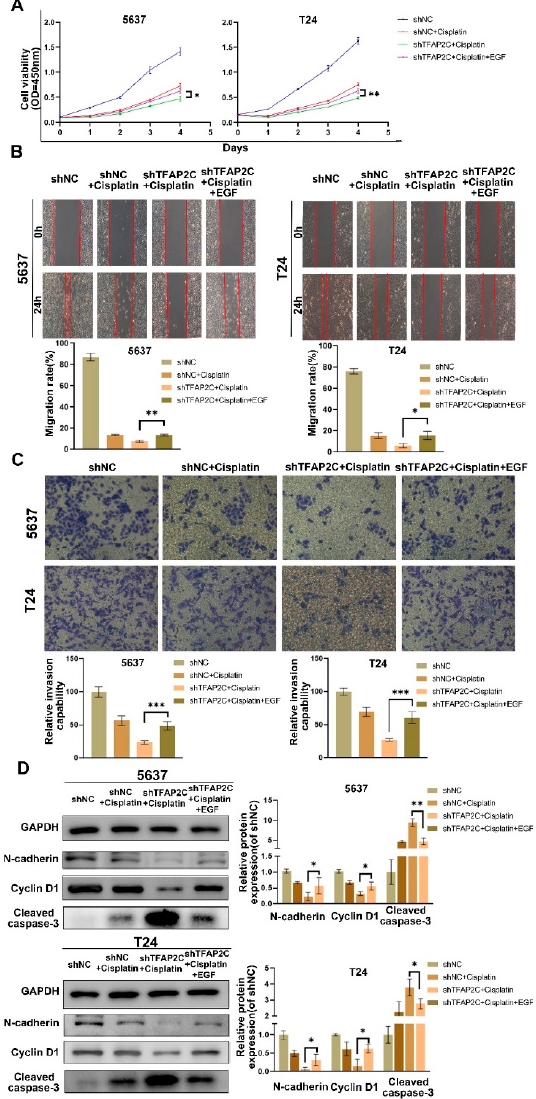
Figure 8. Activation of EGFR with EGF partially reduced the sensitivity of BCa cells to cisplatin. ( A ) Cell viability CCK-8 assay. ( B ) Representative images of the Scratch Assay in 5637 and T24 cells. ( C ) Representative images of the transwell assay. ( D ) Protein expression levels of E-cadherin, cyclin D1, and cleaved-caspase-3. Data represent the mean ± standard deviation (SD) of three independent experiments (* p < 0.05, ** p < 0.01, *** p <